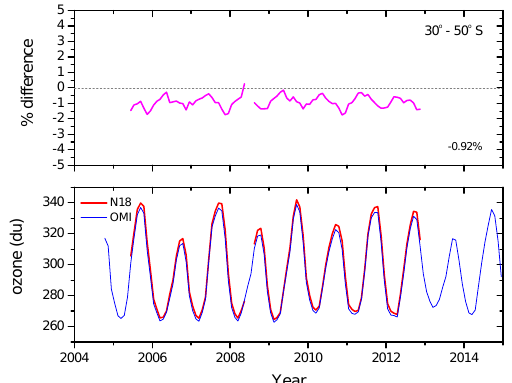
Figure 4. A similar time series albeit averaged from 30 to 50 ◦ S shows that ozone in the Southern Hemisphere was also stable rela- tive to N18 with a seasonal dependance of about